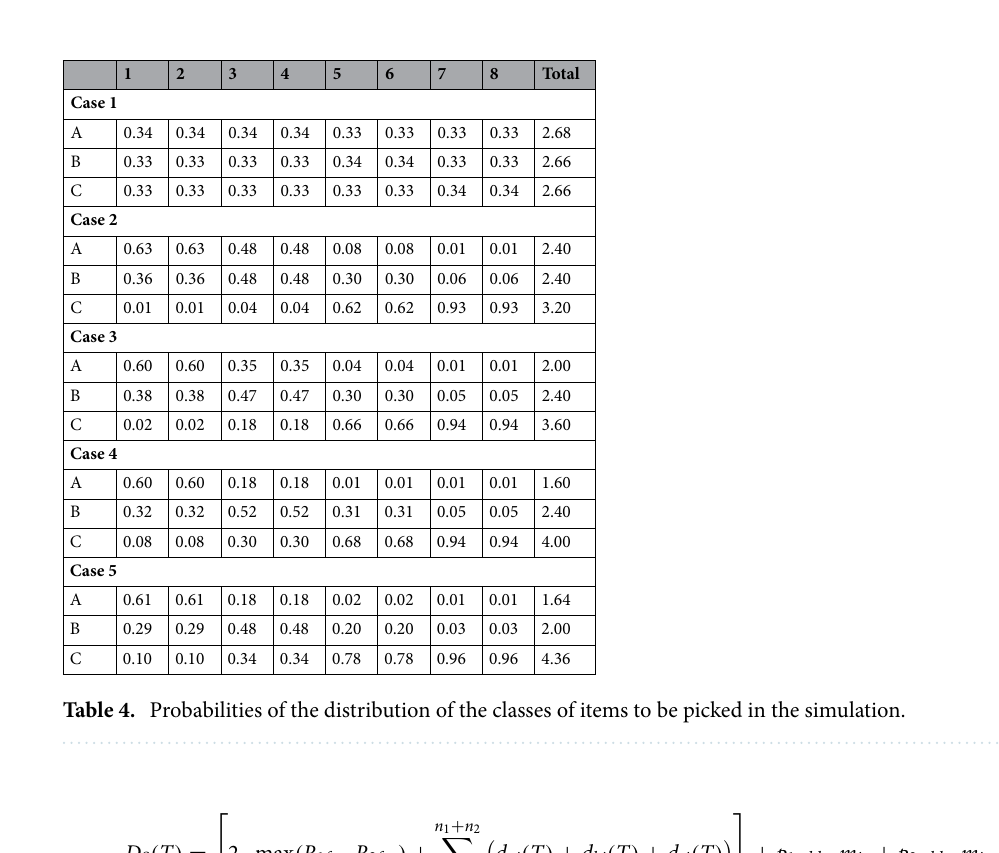
Table 3. Relationship between ordering frequency of item classes and storage space assignment.